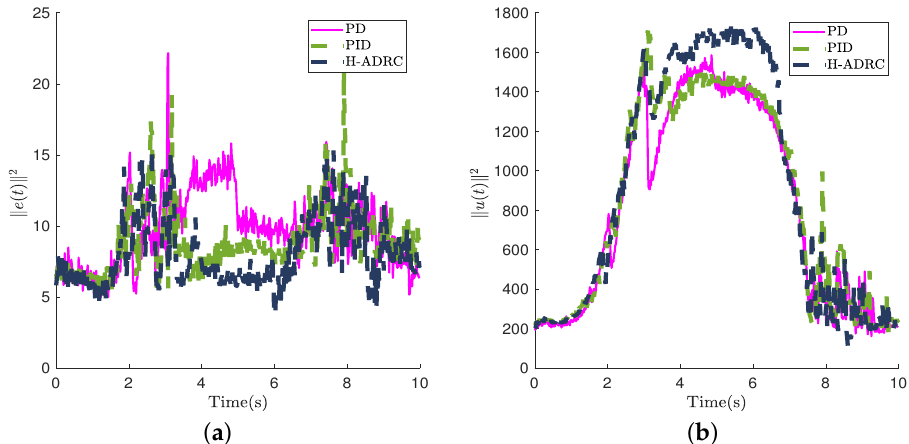
Figure 12. Performance index for each control technique: ( a ) comparison of the Euclidean norm of the tracking error; ( b ) energy used by each controller represented by the evolution of the integral of the square control action u